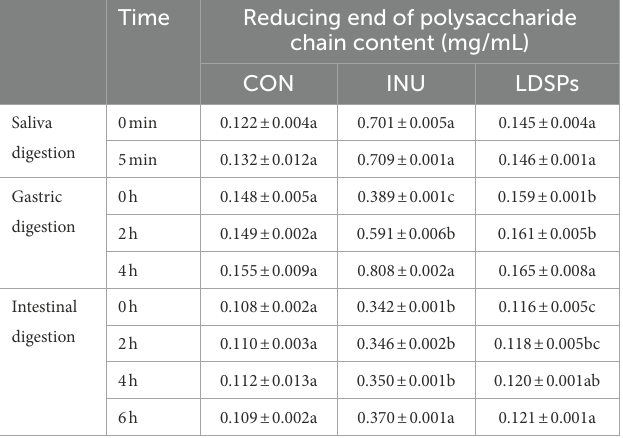
TABLE 2 Changes in reducing end of polysaccharide chain content during in vitro